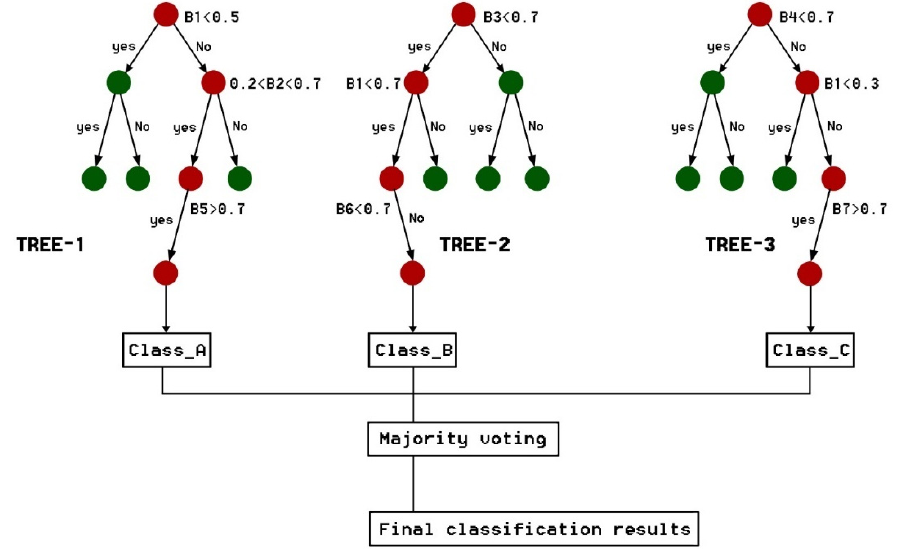
Figure 4. Example of the trees ensemble in the random forest (RF).